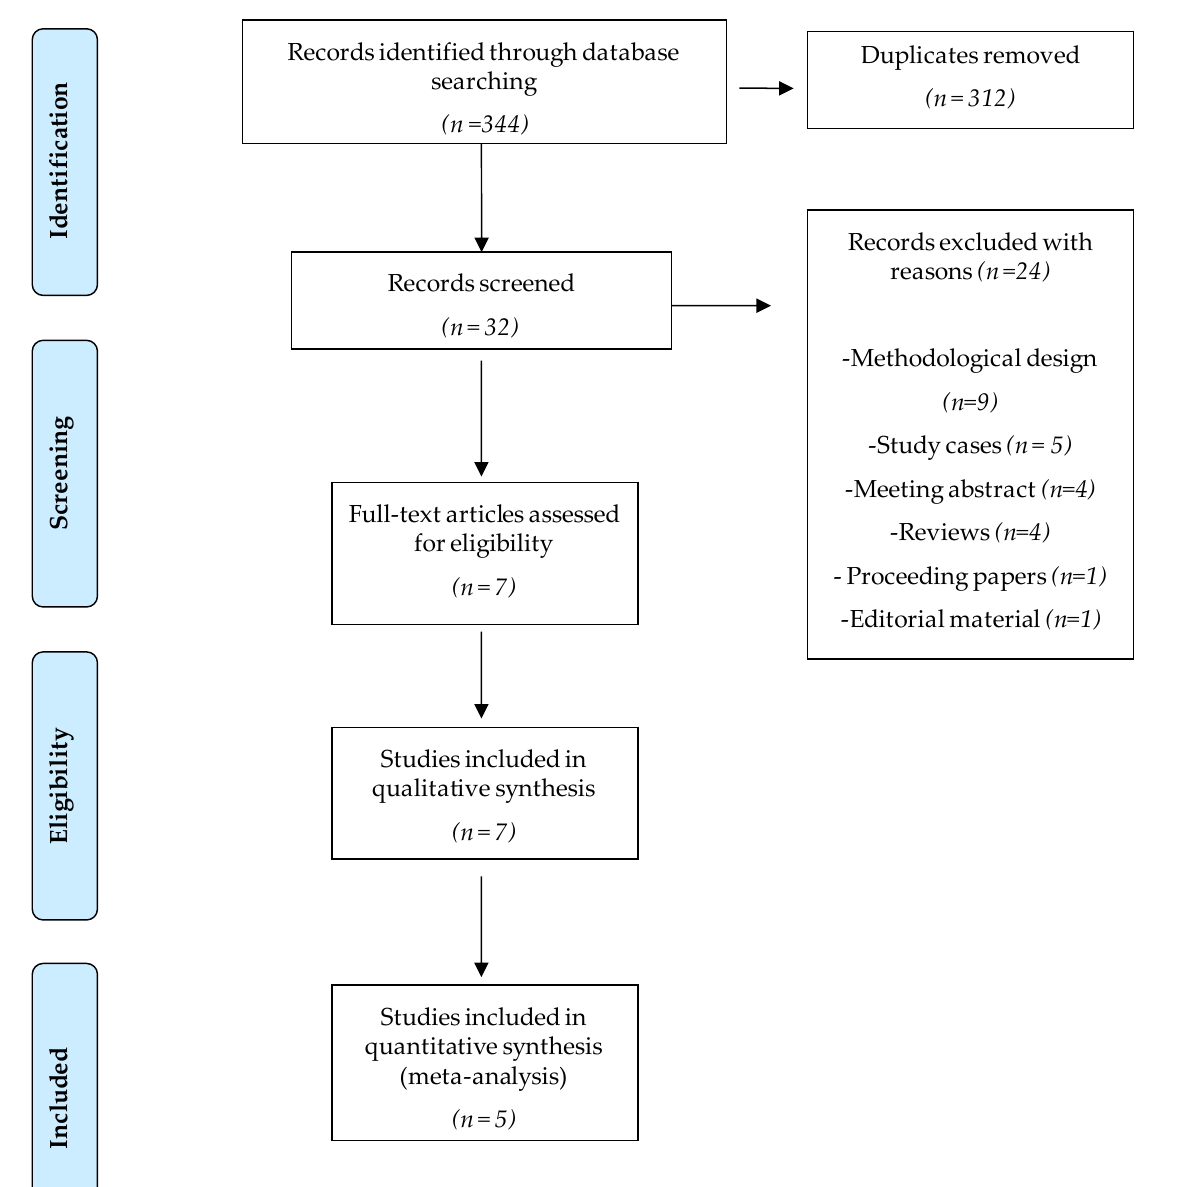
Figure 1. Flow diagram of trial selection based on PRISMA guidelines.